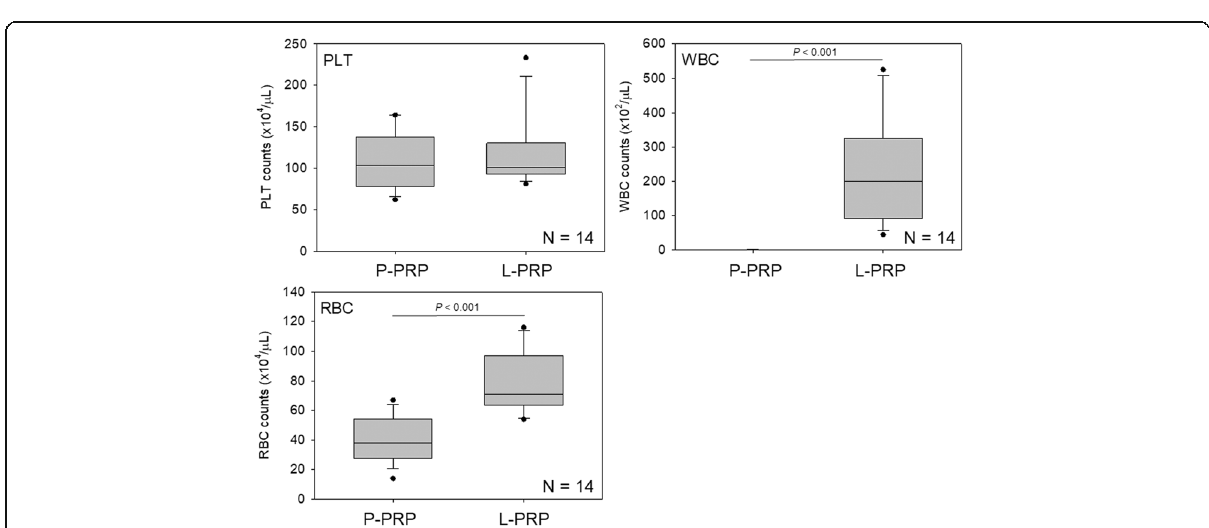
Fig. 3 Counts of platelets (PLT), WBCs, and RBCs in P-PRP and L-PRP preparations prepared for calibration curves. N = 14 for each type of